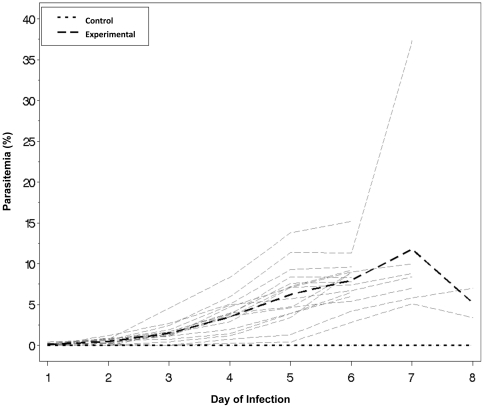
Parasitemia levels in experimental and control mice.Mice inoculated with PbA, as well as non-inoculated controls, were followed daily for parasitemia levels. Mean parasitemia on day 5 was 3.5%, with a peak of 11.8% on day 8 (including an outlier of 37%). Light gray lines represent individual subjects, and the two darker lines represent the mean levels from the experimental mice (dark dashed line, n = 16) and the control mice (dark dotted line, n = 3).